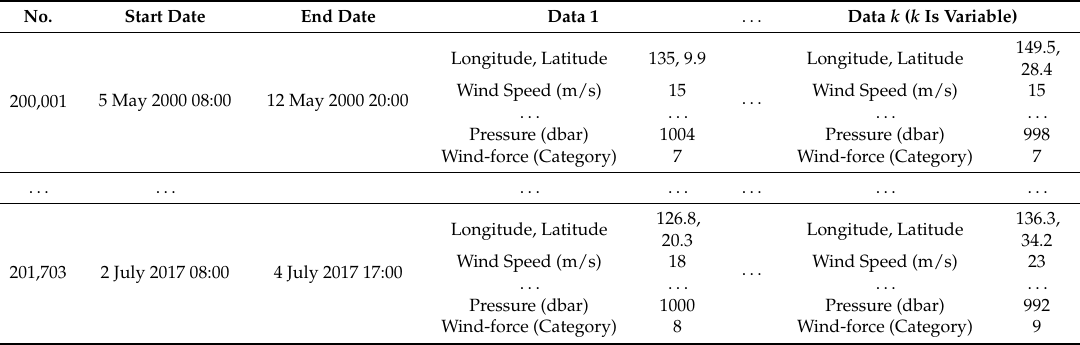
Table 3. Samples of typhoon